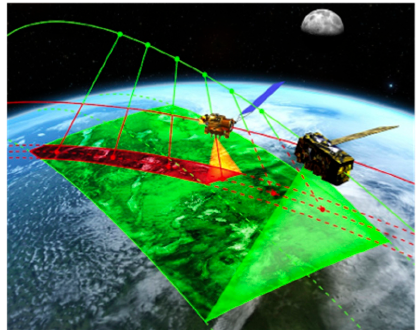
Figure 1. Free flyer concept using active pointing to match CLARREO scans (red) across the Suomi National Polar-orbiting Partnership (SNPP) satellite instrument scan width (green).